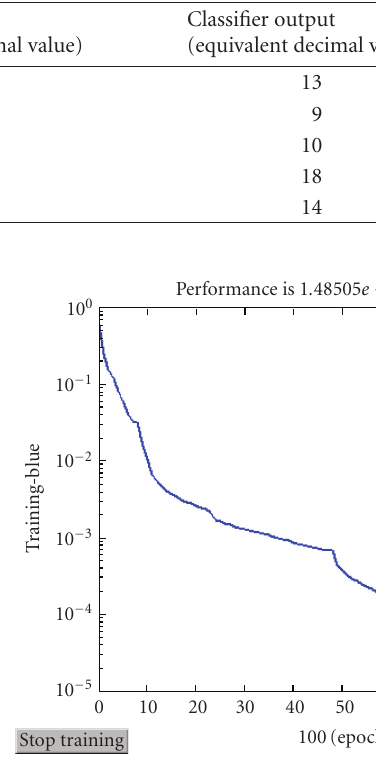
Figure 8: Performance plot for the classifier.